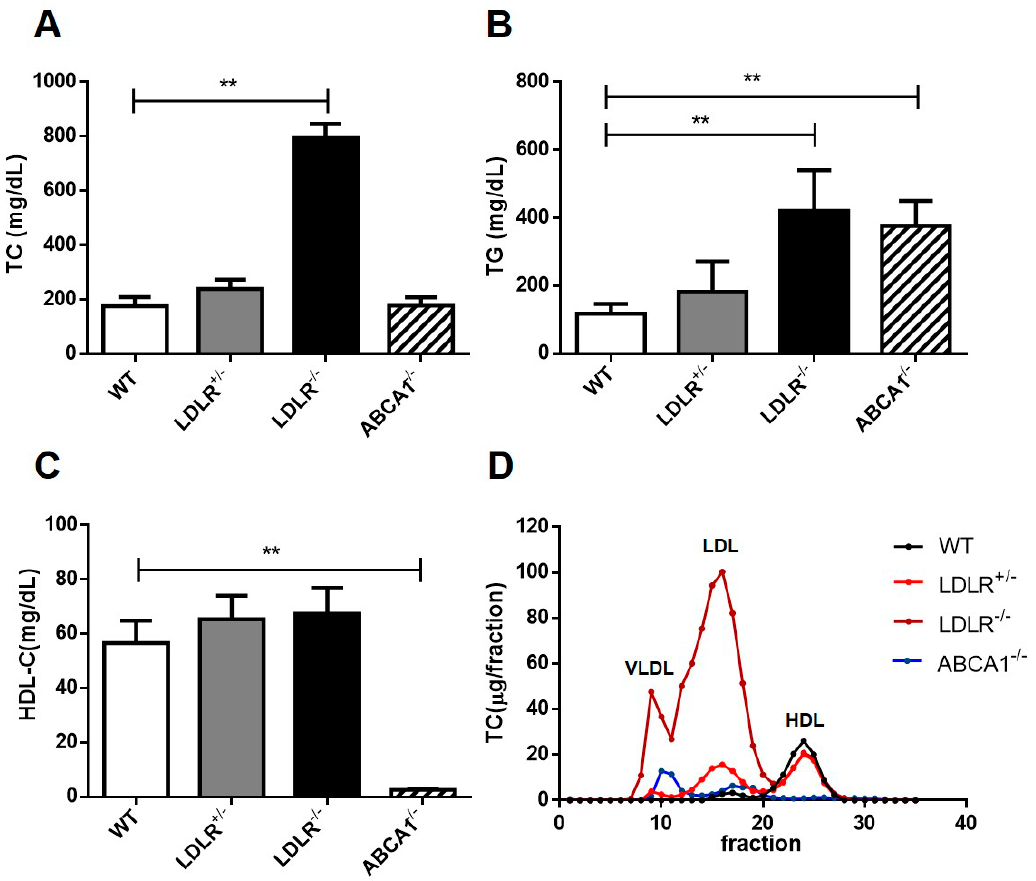
Figure 3. Analysis of plasma lipid profiles in di ff erent ischemic hamster models fed on chow diet. ( A–C ) Plasma total cholesterol (TC) ( A ), triglyceride (TG) ( B ) and high-density lipoprotein cholesterol (HDL-C) ( C ) were determined in male WT, LDLR +/ – , LDLR – / – and ABCA1 – / – hamsters after 12 h fasting ( n = 8 / group). ( D ) Fast-protein liquid chromatography (FPLC) analysis of the lipoprotein distribution in pooled plasma from di ff erent groups ( n = 6 / group). Data are expressed as mean ± SD. * p < 0.05; ** p < 0.01 versus WT group.